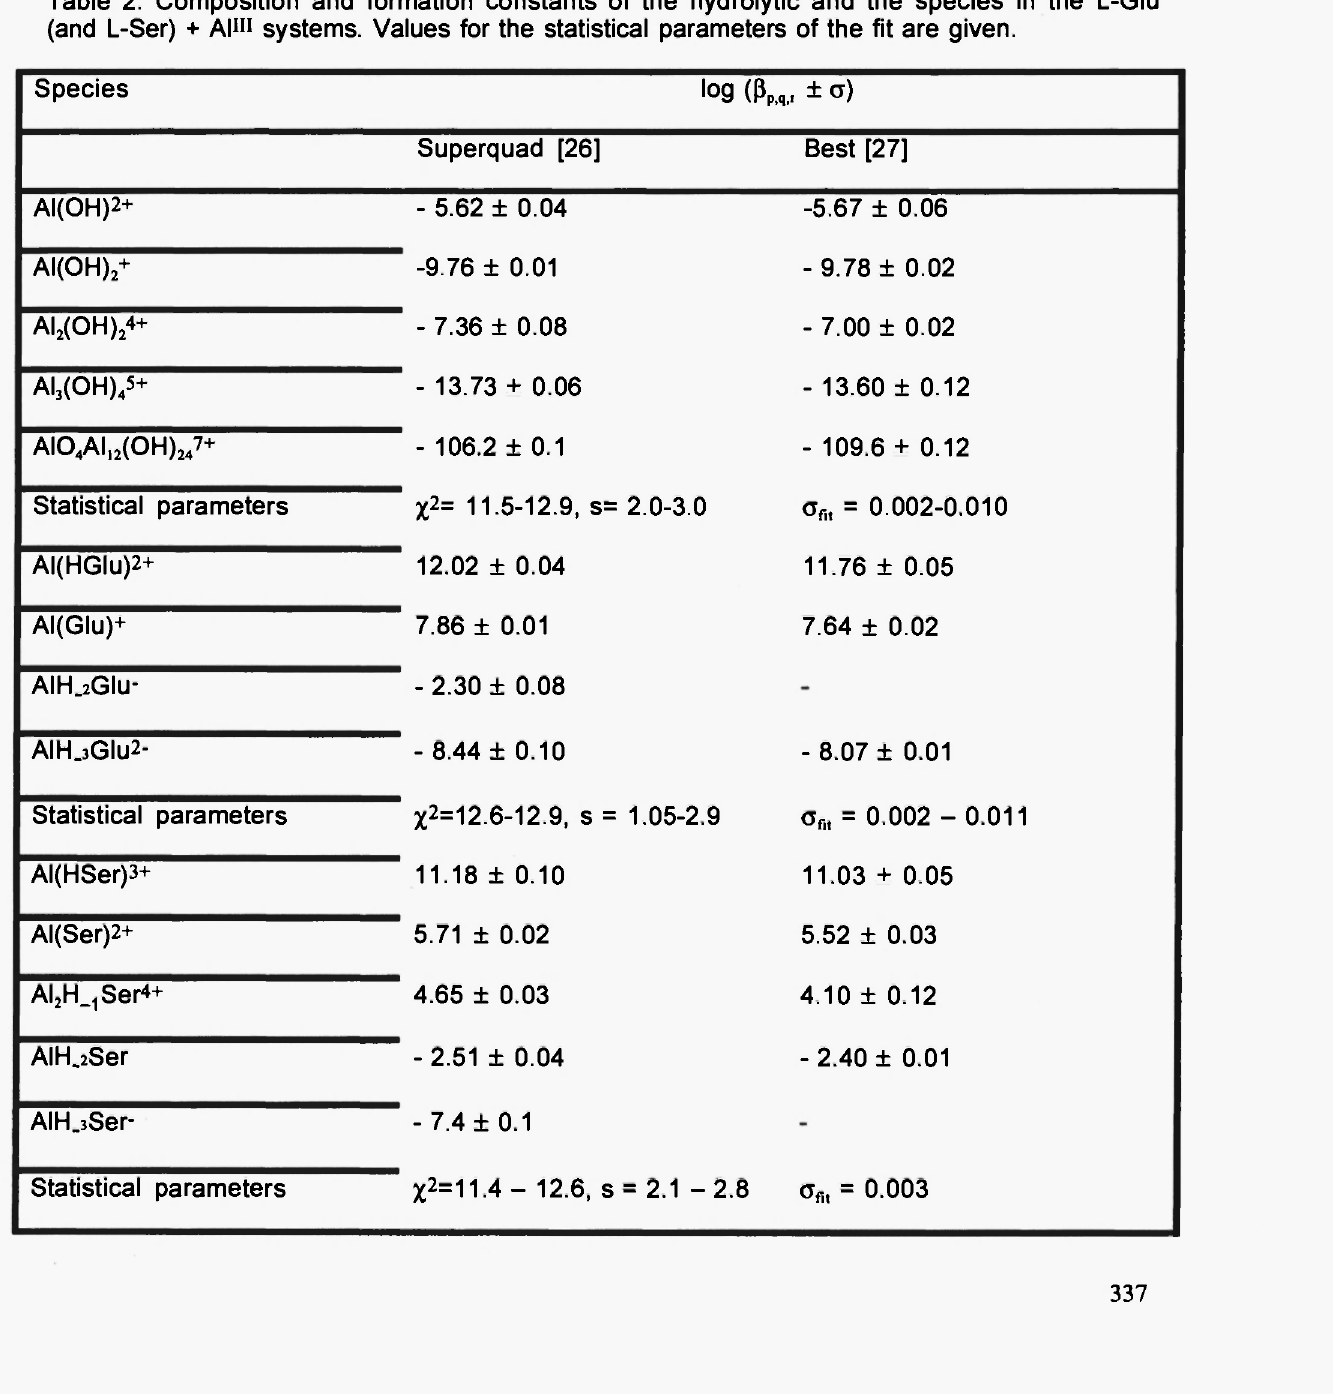
Table 2. Composition and formation constants of the hydrolytic and the species in the L-Glu (and L-Ser) + Al m systems. Values for the statistical parameters of the fit are